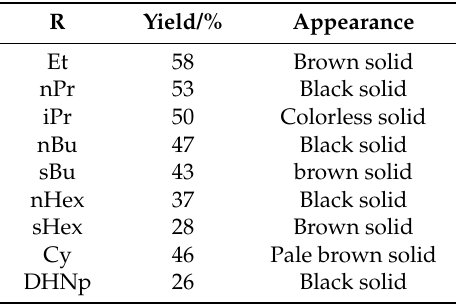
Table 2. Ceramic yield and appearance of 800 ◦ C-pyrolyzed